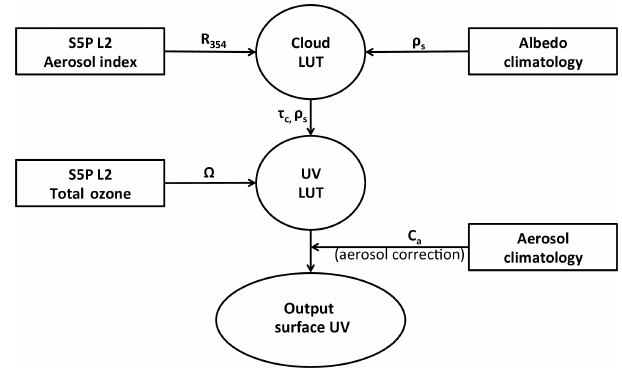
Figure 1. Schematic flow chart of the TROPOMI UV algorithm. See text for